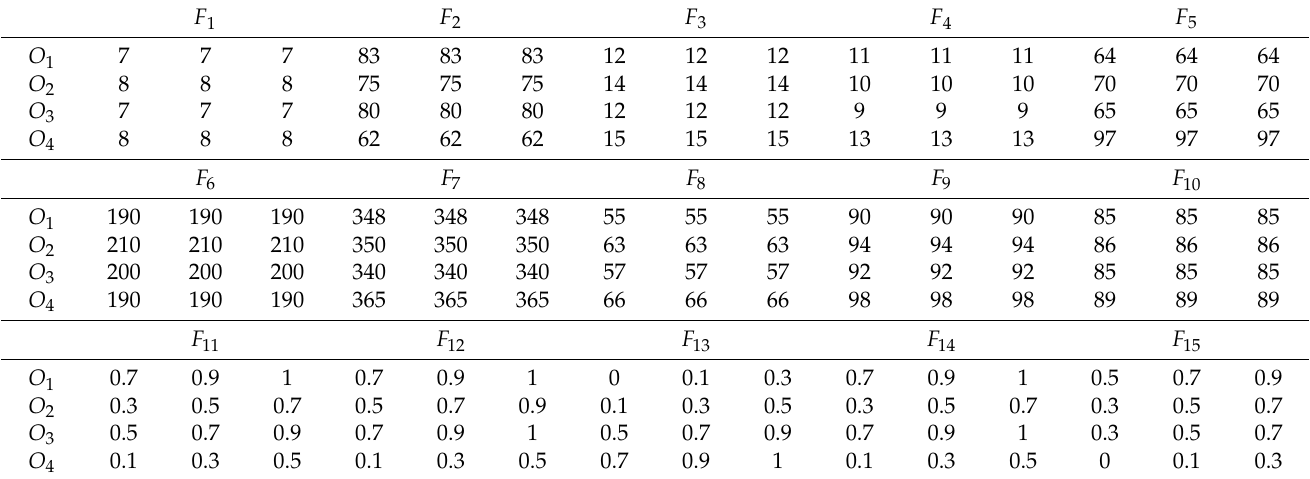
Table 14. The ratings of the alternatives versus qualitative and quantitative